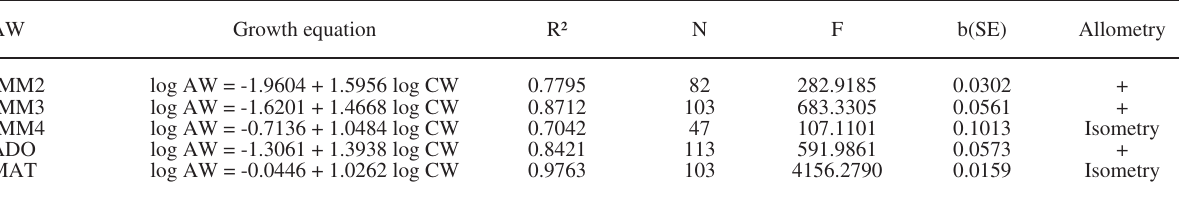
Table 1. – allometric growth equations of juvenile stages (iMM2, iMM3, iMM4 and ado) and adult females (MaT), using abdomen width as a reference variable. aW= abdomen width. cW = cefalothorax width. The number of crabs and their standard error are shown. P<0.00001 in all cases. allometric status is added (t 0.05